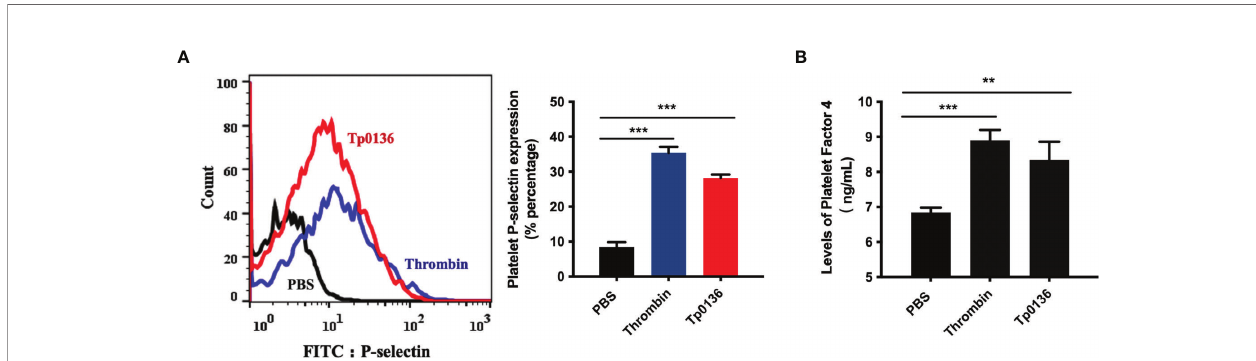
FIGURE 2 | Tp0136 promoted human platelet activation. (A) Expression of platelet P-selectin as measured by fl ow cytometry. A representative histogram is shown. Statistical data were analyzed using the X geometric mean fl uorescence (left) and the percentage of gated cells (right). (B) PF4 expression as determined by ELISA. The values are presented as the mean ± SEM of experimental triplicates and are representative of the results of three independent experiments. Values among multiple groups were compared by one-way ANOVA (** P < 0.01, *** P <